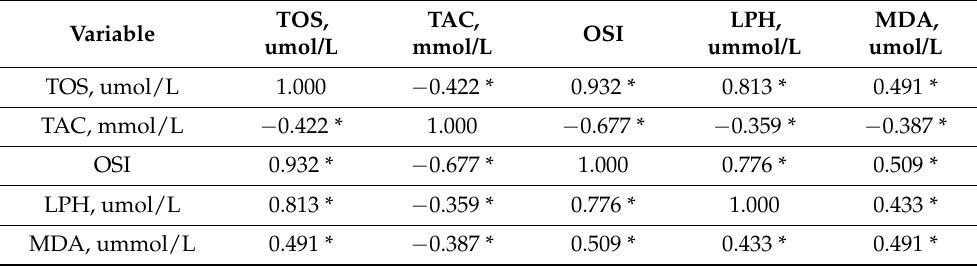
Table 6. Spearman’s rank correlation coefficients between analyzed parameters of oxidative– antioxidant balance in the analyzed